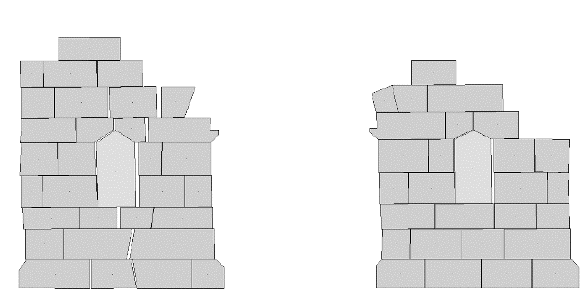
Figure 15. Structure damaged during the 3rd